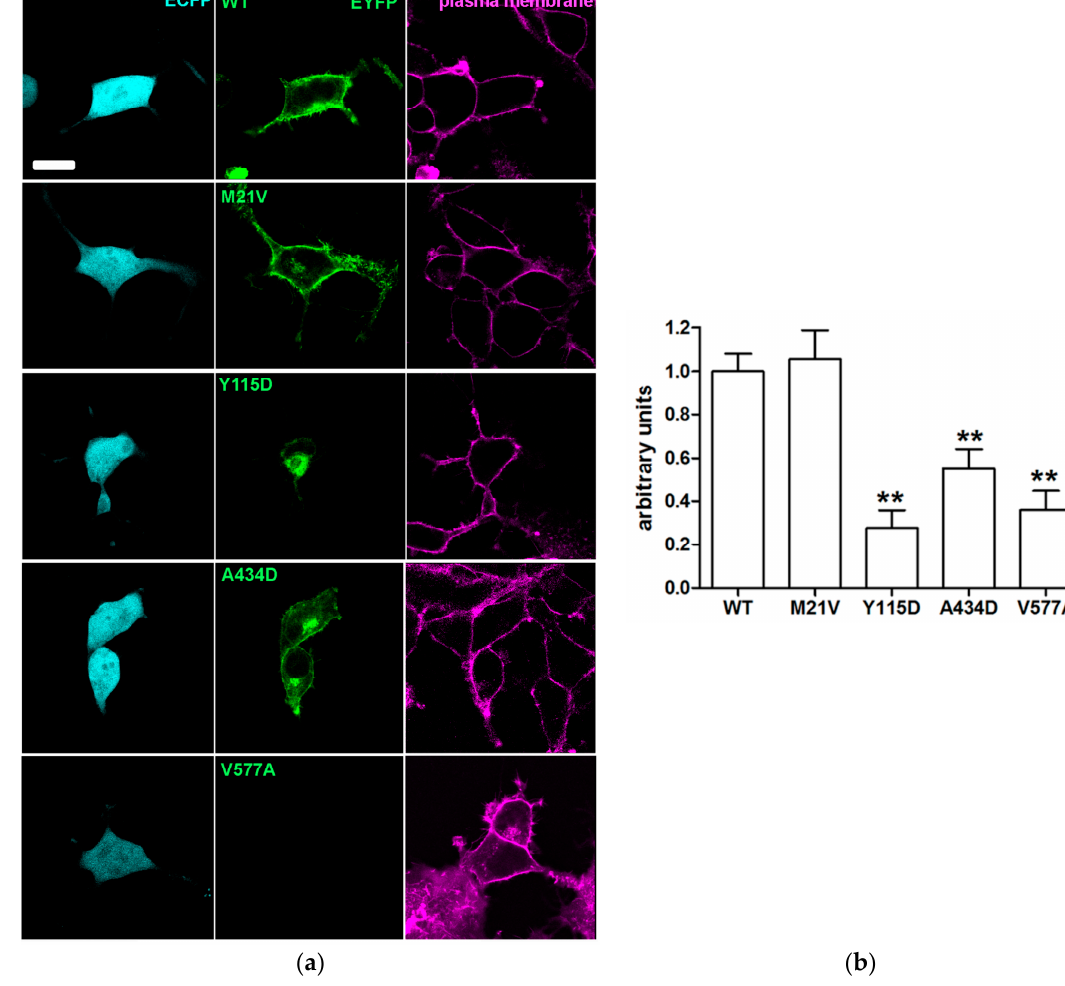
Figure 5. Abundance of wild type pendrin and its variants in the plasma membrane region of living cells. ( a ) From left to right: fluorescent signal of the transfection marker enhanced cyan fluorescent protein (ECFP, cyan), EYFP fused to the C-terminus of the indicated pendrin variants expressed in HeLa cells for 72 h (green), and plasma membrane (magenta). Scale bar: 15 µm; ( b ) Wild type (WT) and mutated pendrin fluorescence intensity in three regions of interest of the plasma membrane of a single cell were expressed as levels of grey, averaged and normalized for the fluorescence intensity of ECFP in the cytosol of the same cell. Error bars represent SEM. n = 24, ** p < 0.01 compared to wild type, one-way ANOVA with Bonferroni’s multiple comparison post-test. ( n ) refers to the number cells from 6 independent experiments.